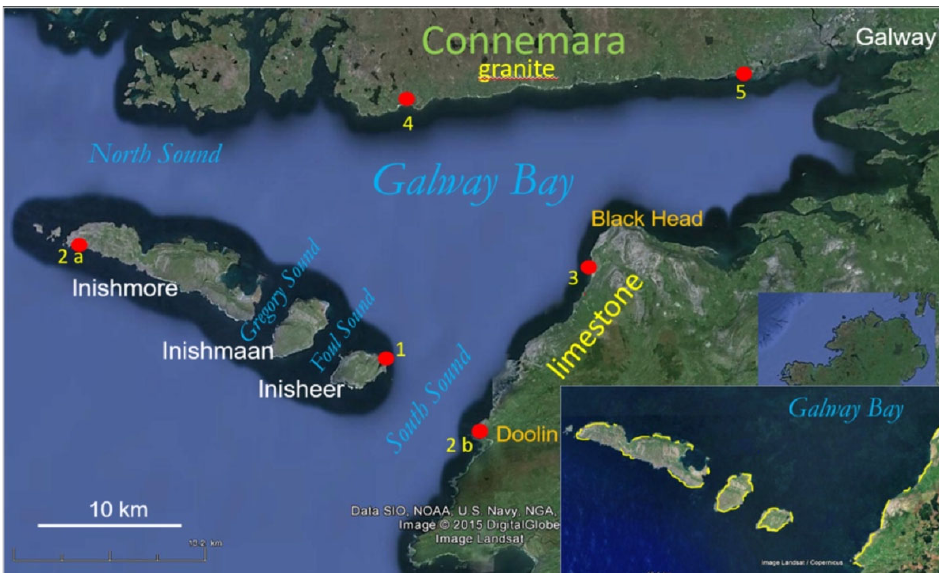
Figure 2. Localities and methods for mid ‐ Holocene sea ‐ level reconstruction at − 5 m mhw in Galway Bay and at the Aran Islands, central west coast of Ireland. 1 —by micropaleontology in karst lake; 2a , b —by drowned soil with charcoal; 3 —by drowned sand deposit for a now ‐ inactive dune field; 4 —by Bronze Age tomb in surf level; 5 —by drowned freshwater peat with birch and oak and Neolithic canoe. Insert shows extension of boulder deposits (yellow lines) along the Aran Islands and the southeast coast of Galway Bay altogether for about 35 km.